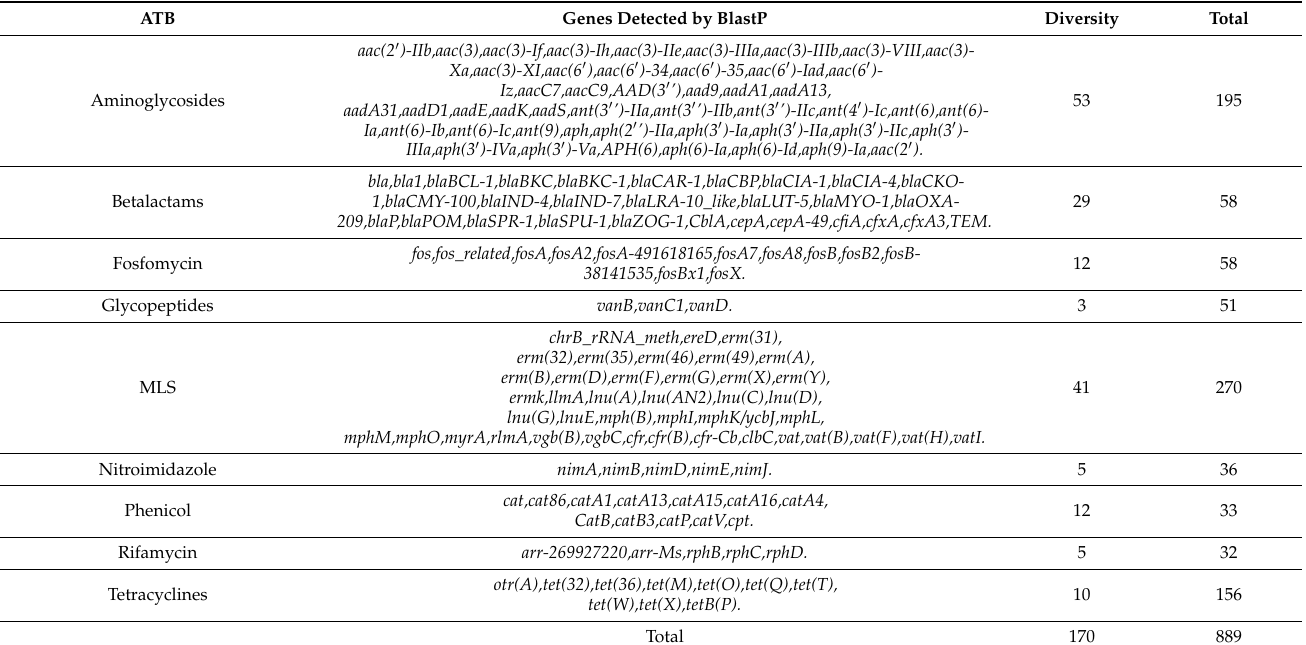
Table 1. Distribution and diversity of resistance genes found by BlastP listed by antibiotic